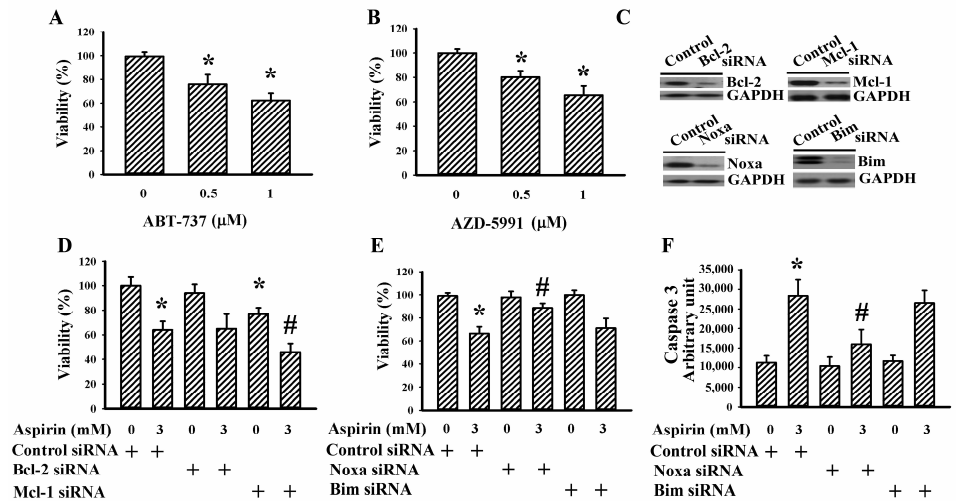
Figure 3. Bcl-2 family proteins are crucial to aspirin-induced apoptosis in H4 cells. H4 cells were treated with various concentrations of ABT-737 (0–1 µM) ( A ) or AZD5991 (0–1 µM) ( B ) for 2 days. Cell viability was measured by the MTS reduction assay. ( C ) H4 cells were transfected with control siRNA (1 nM), Bcl-2 siRNA (1 nM), Mcl-1 siRNA (1 nM), Noxa siRNA (1 nM), or Bim siRNA (1 nM) for 2 days. Proteins were extracted and subjected to Western blot with indicated antibodies. ( D ) H4 cells were first transfected with control siRNA (1 nM), Bcl-2 siRNA (1 nM), or Mcl-1 siRNA (1 nM) for 24 h. The transfected cells were then treated with aspirin (0 and 3 mM) for 2 days. Cell viability was measured by the MTS reduction assay. H4 cells were first transfected with control siRNA (1 nM), Noxa siRNA (1 nM), or Bim siRNA (1 nM) for 24 h. The transfected cells were then treated with aspirin (0 and 3 mM). Cell viability (2 days) was measured by the MTS reduction assay ( E ). Proteins (24 h) were extracted and subjected to enzymatic assay of caspase 3 activity ( F ). * p < 0.05 vs. untreated control/control siRNA and # p < 0.05 vs. aspirin (3 mM)/control siRNA, n = 4.